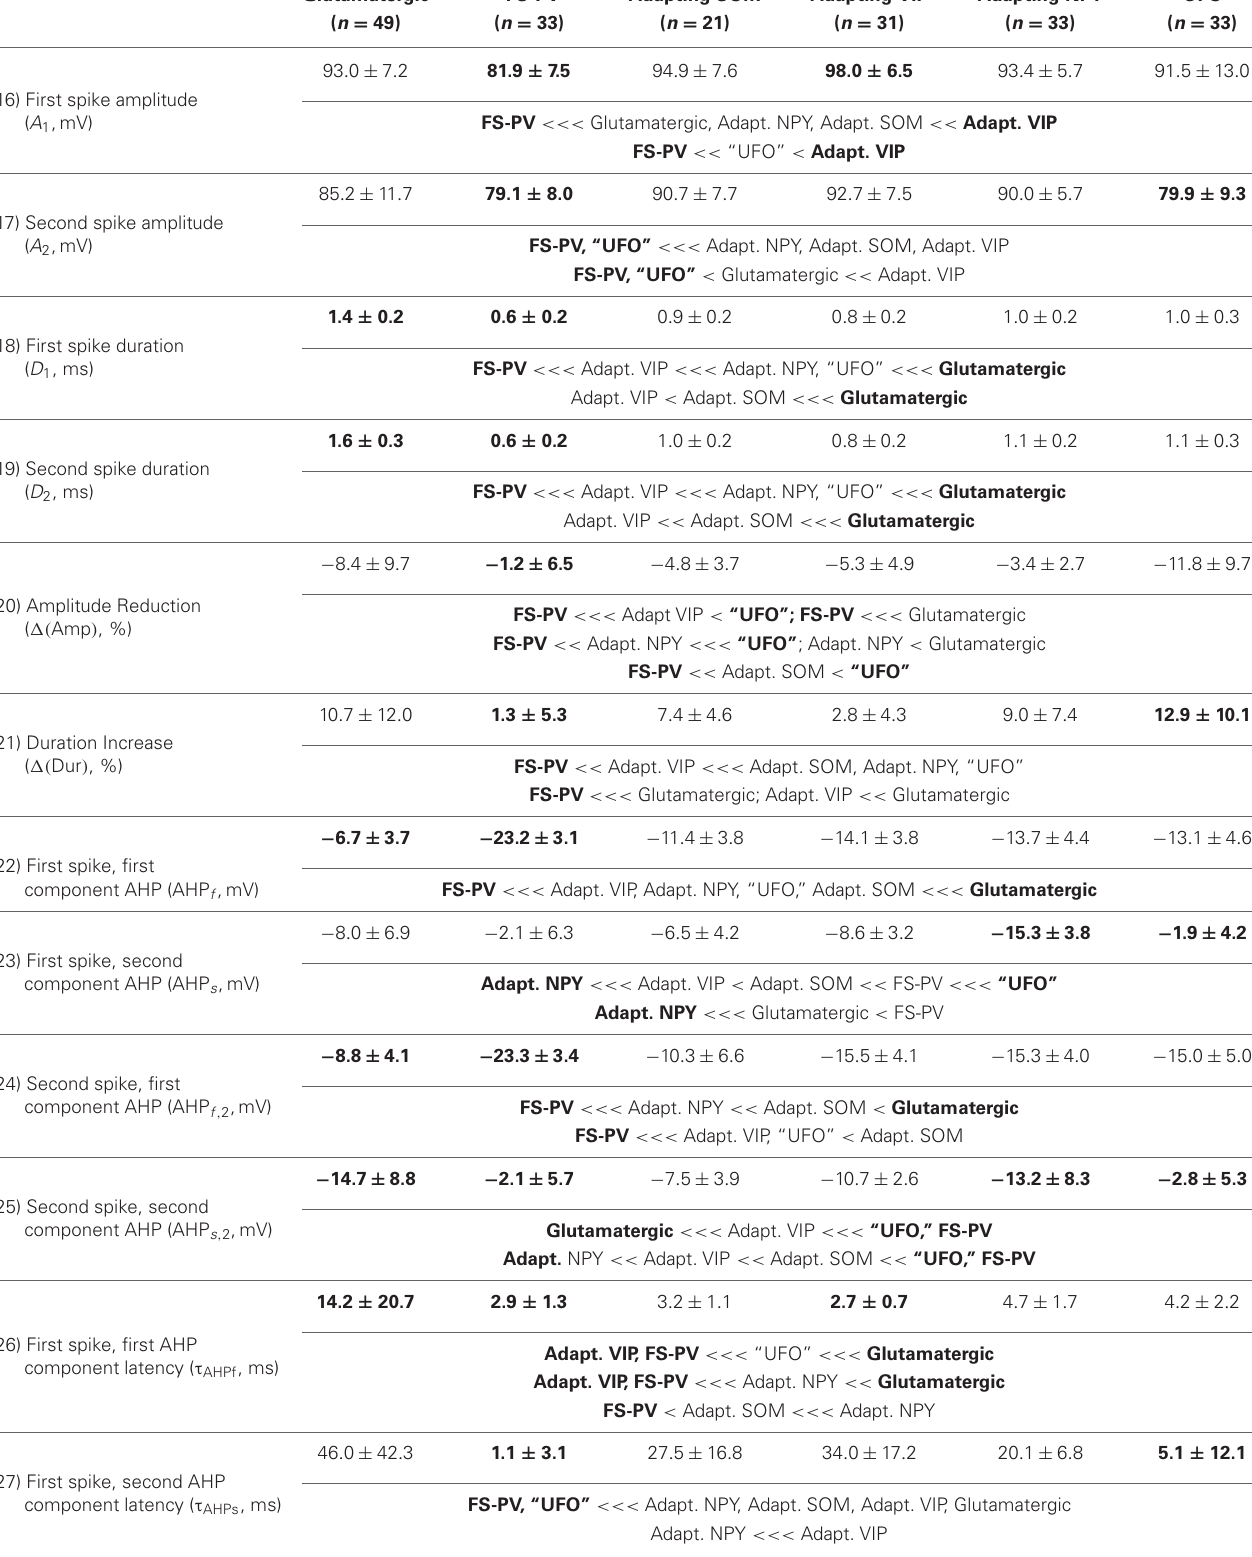
Table 3 | Action potentials features of different archetypes. Glutamatergic FS-PV Adapting SOM Adapting VIP Adapting NPY